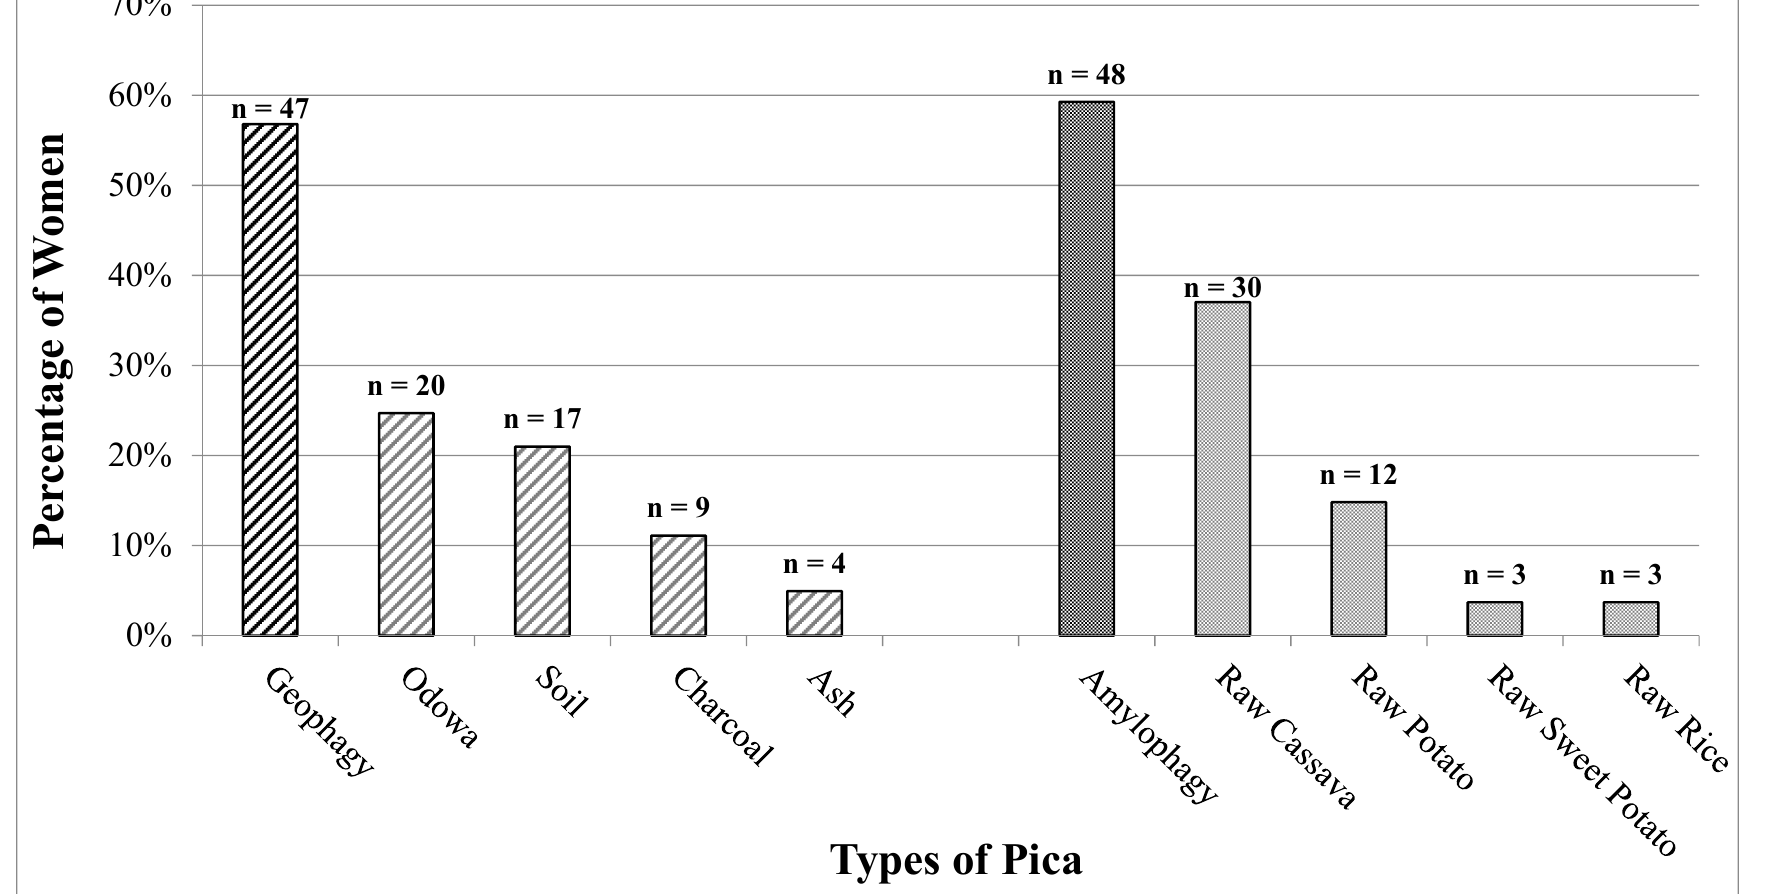
Figure 1. Types of pica substances reportedly consumed among women in the previous 24 h. Percentages were calculated out of the total number of women reporting any form of pica ( n = 81). Sixteen women reported consuming two or more substances, with n = 13 reporting both geophagy, charcoal, and/or ash consumption and amylophagy.